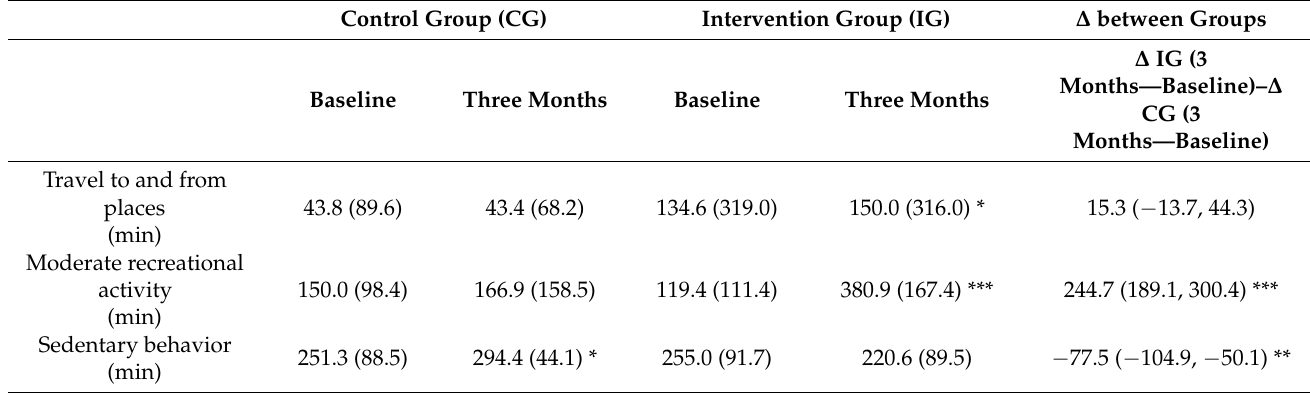
Table 2. Patients’ physical activity level.